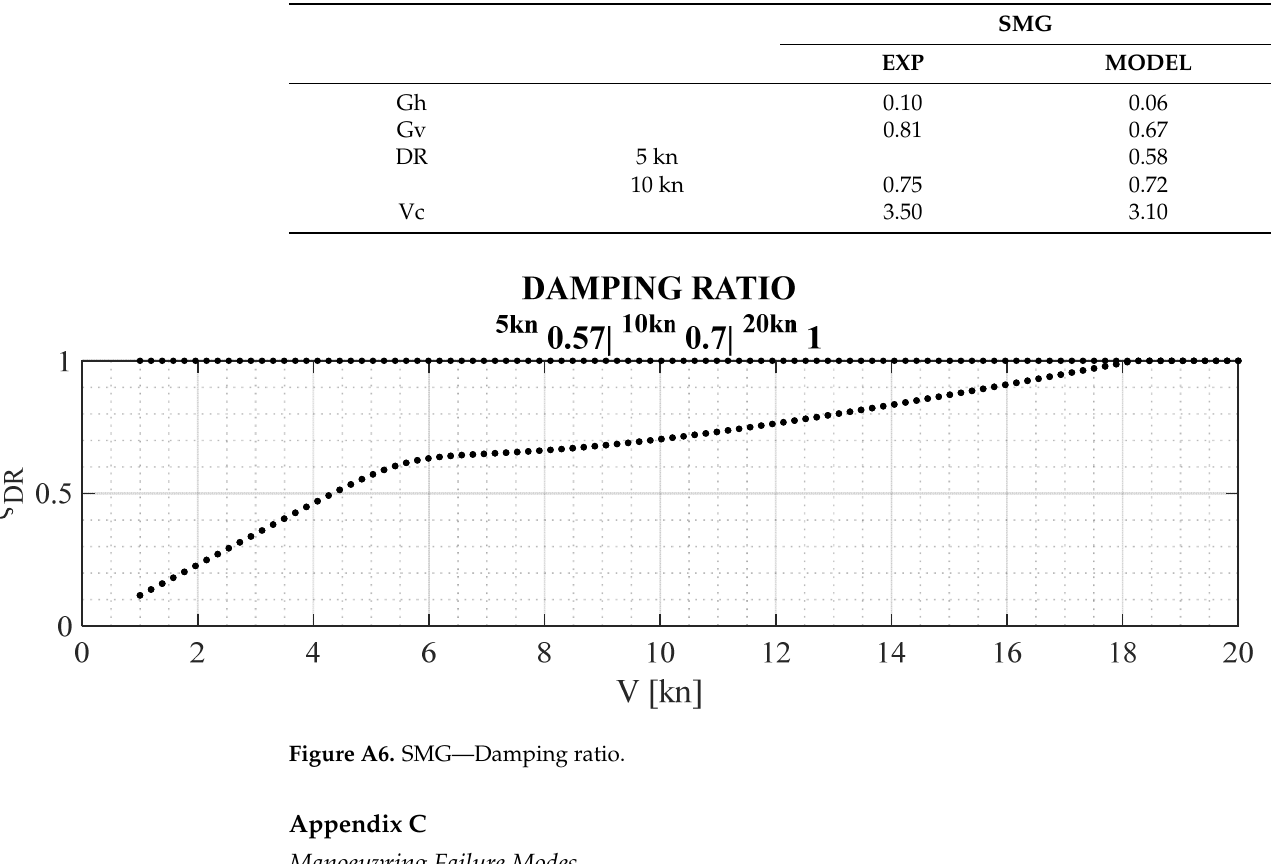
Table A1. Linear stability indexes validation.